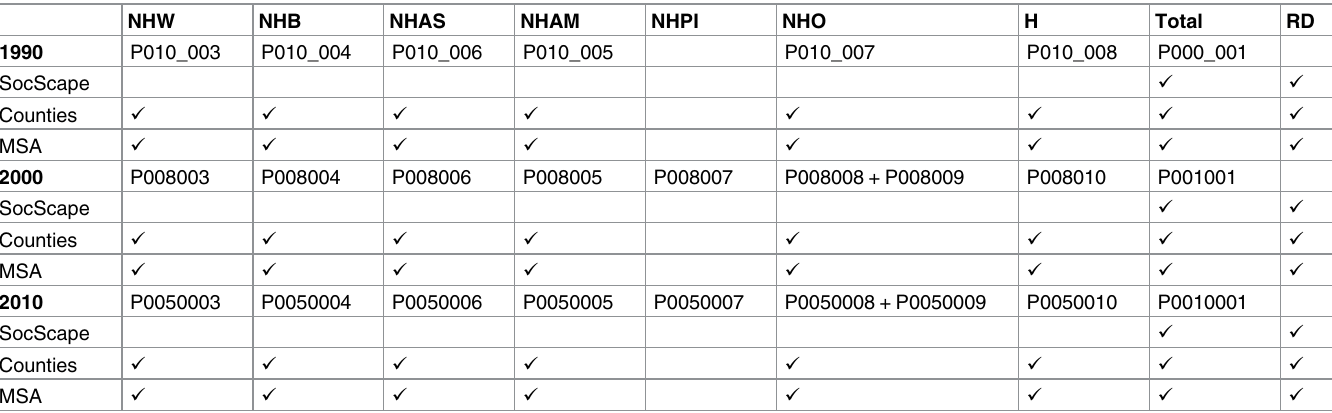
Table 2. Availability of grid population